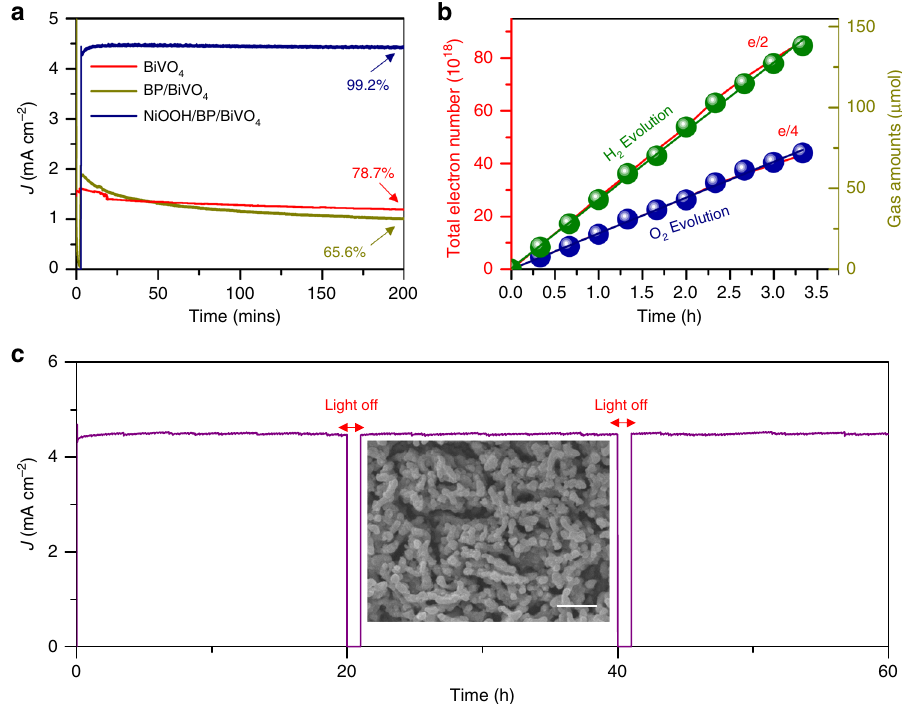
Fig. 5 a Photocurrent density stability measured at 1.23 V vs RHE in KPi electrolyte (pH = 7.1) under AM 1.5 illumination. b Plots of the theoretical charge number obtained from the J – t curves collected at 1.23 V vs. RHE and the actual quantities of H 2 and O 2 evolution in KPi electrolyte (pH = 7.1) under AM 1.5 illumination. c Long-term stability of the NiOOH/BP/BiVO 4 photoanode at 1.23 V vs RHE in KPi electrolyte (pH = 7.1) under AM 1.5 illumination, insert is SEM image after long-term testing, scan bar: 1 μ m